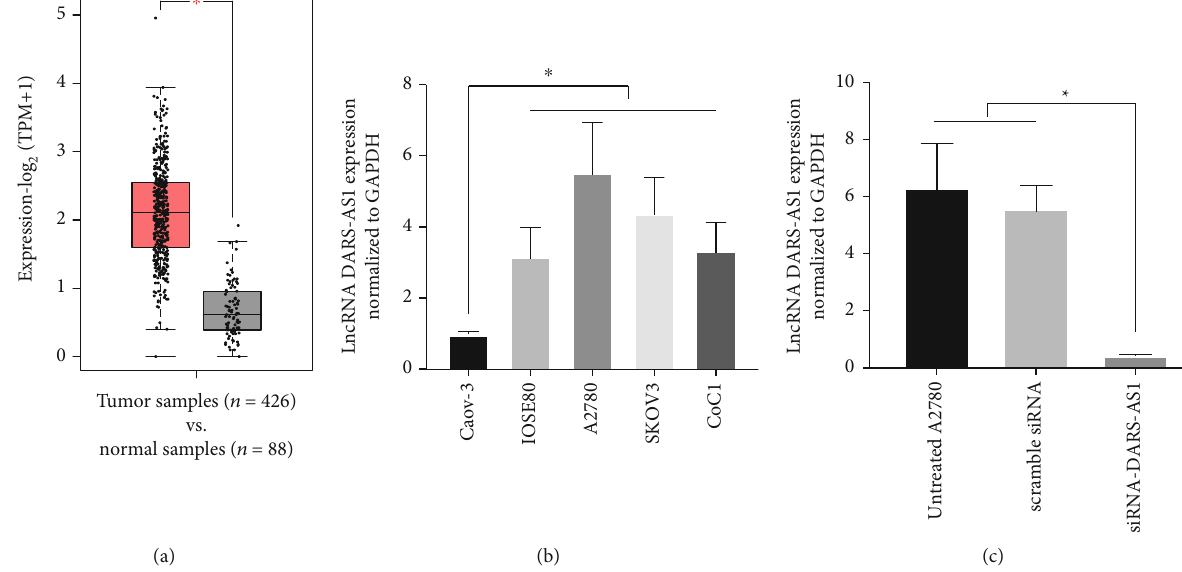
Figure 1: OC cell model shows upregulated lncRNA DARS-AS1. (a) GEPIA 2 database analysis showing DARS-AS1 is upregulated in OC. (b) qRT-PCR detection of DARS-AS1 expression in OC cell model and normal cell lines. (c) lncRNA DARS-AS1 knockdown cells using the lncRNA DARS-AS1 siRNA oligonucleotides. A symbol of ∗ represents p < 0 : 05